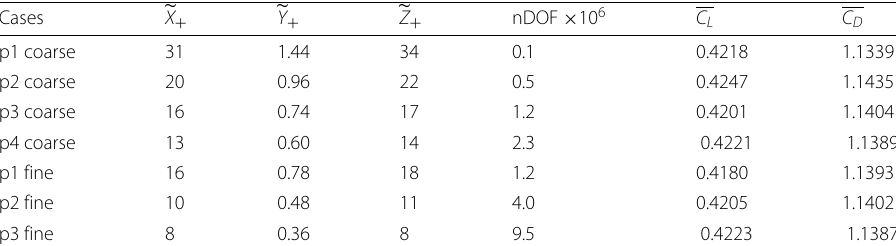
Table 1 Simulation data including, average mean C L and C D coefficients